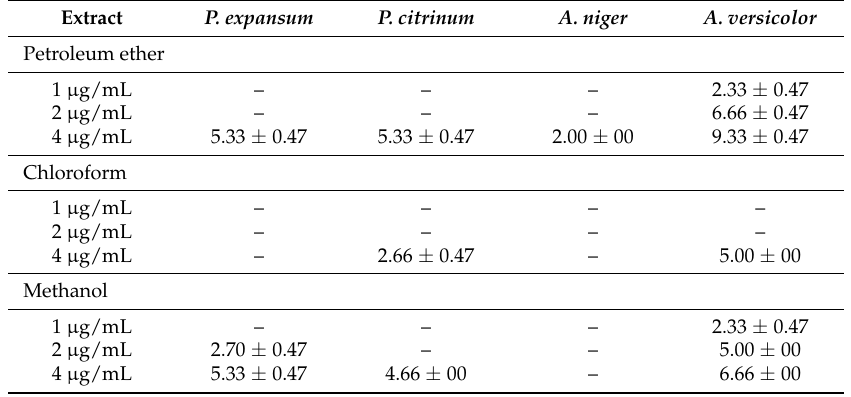
Table 5. Antifungal activity of petroleum ether, chloroform, and methanol extracts of P. aculeata.